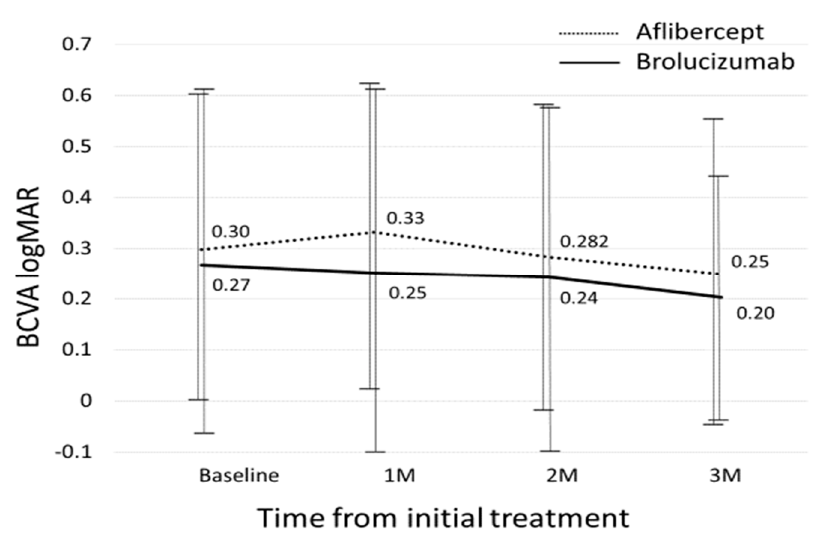
Figure 1. Changes in best-corrected visual acuity between the brolucizumab-treated and aflibercept- treated groups.